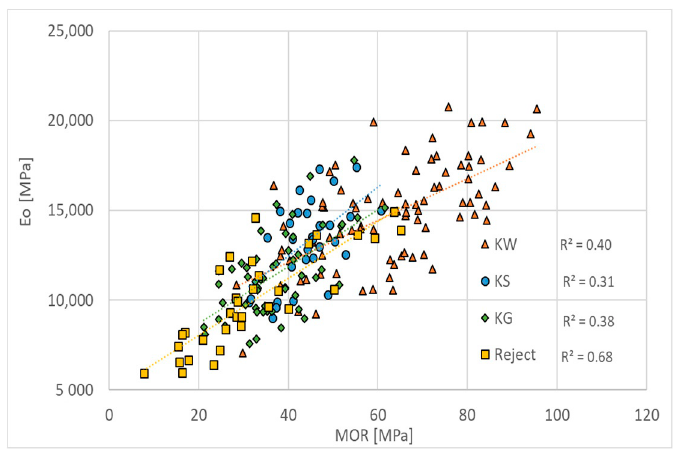
Figure 3. Correlations between the modulus of elasticity parallel to the grain and static bending strength, taking strength grades into account.